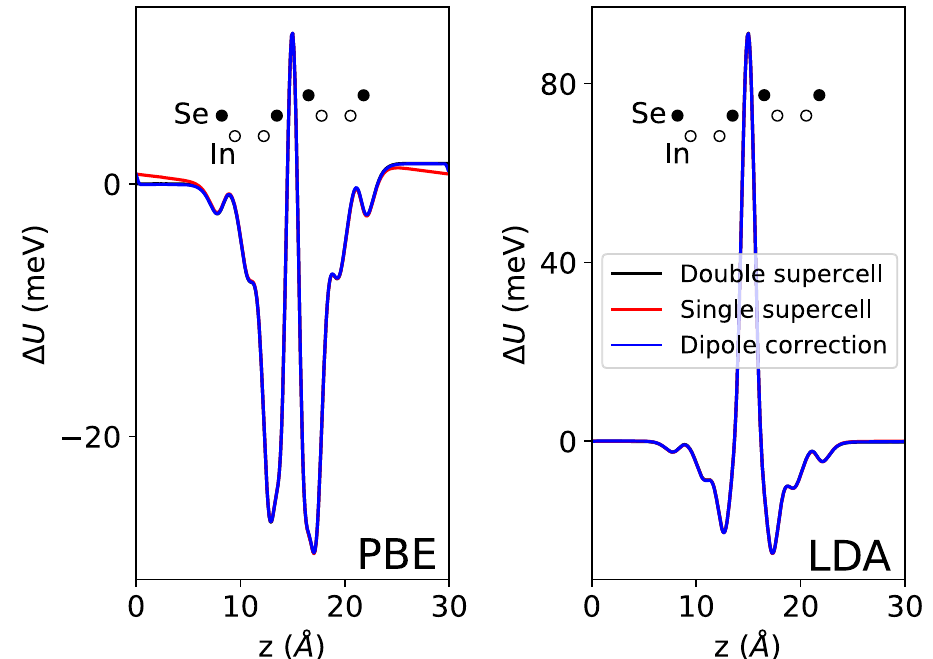
Figure 3. Left panel: difference between bilayer and isolated monolayer plane-averaged local potentials for 3R-stacked bilayer InSe, comparison between supercell methods. Right panel: same as left panel, but calculated using LDA. 0 meV is set to the double-supercell vacuum level on the Se side of the vertical In-Se pair.